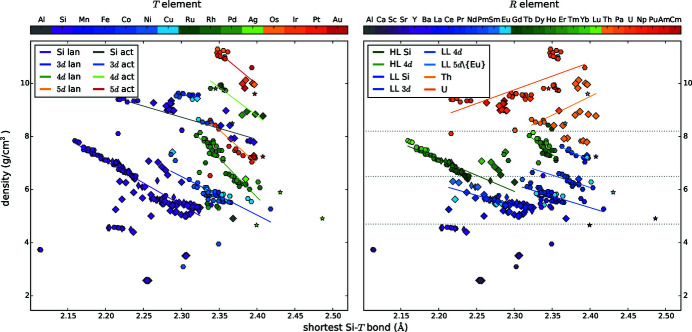
Correlations between the density and the shortest Si—T distance d. The R element strongly determines the density. The density linearly depends on the chosen R and T elements. With increasing atomic number of the R elements, r
R increases and thus d decreases and simultaneously the density decreases. With increasing atomic number of the T elements, r
T increases and thus d increases and simultaneously the density increases.